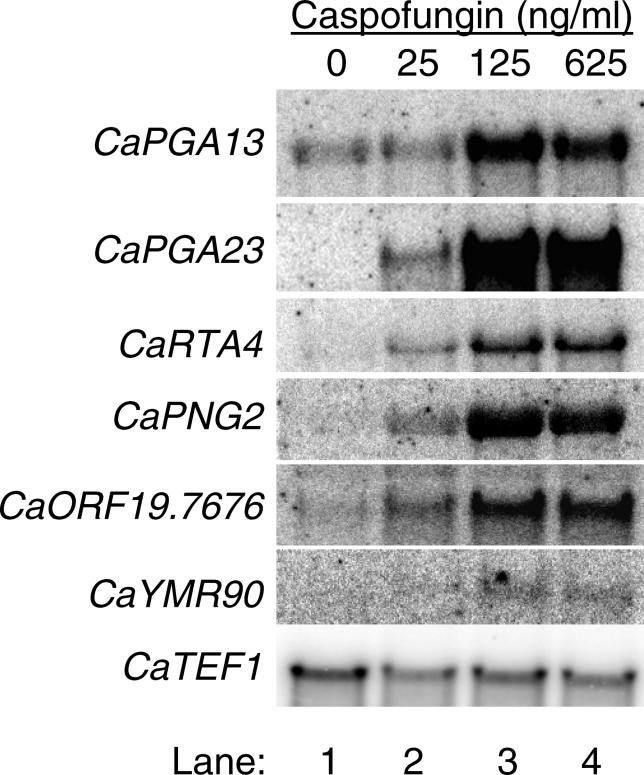
Expression of Caspofungin-Responsive GenesWild-type reference strain DAY185 was grown in YPD medium at 30 °C to midexponential phase, and aliquots of the culture received caspofungin at the indicated final concentration. After 1 h of further incubation, RNA was prepared for Northern blot analysis and probed for the indicated transcripts. CaTEF1 was used as a loading control.